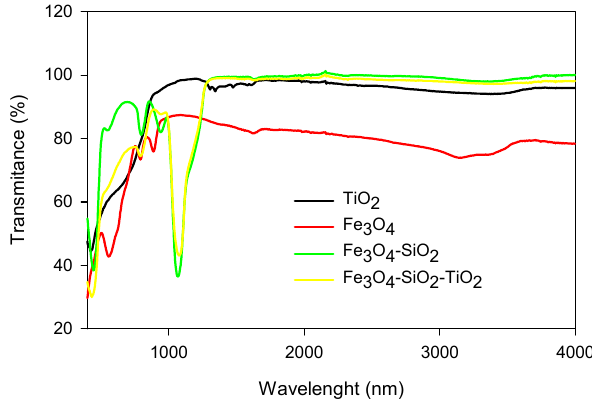
Figure 4. FTIR spectra of the Fe 3 O 4 –SiO 2 –TiO 2 catalyst and the synthesis steps.